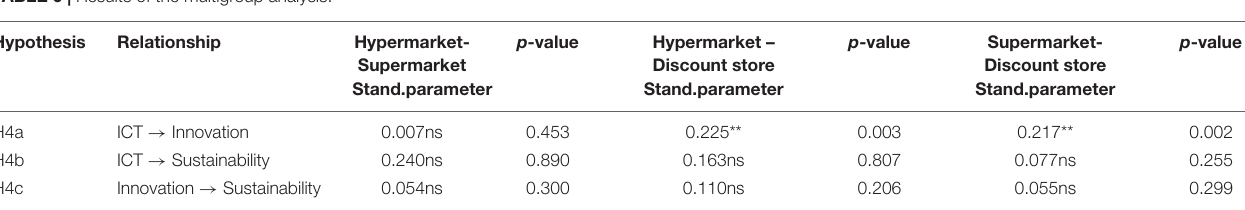
TABLE 6 | Results of the multigroup analysis.